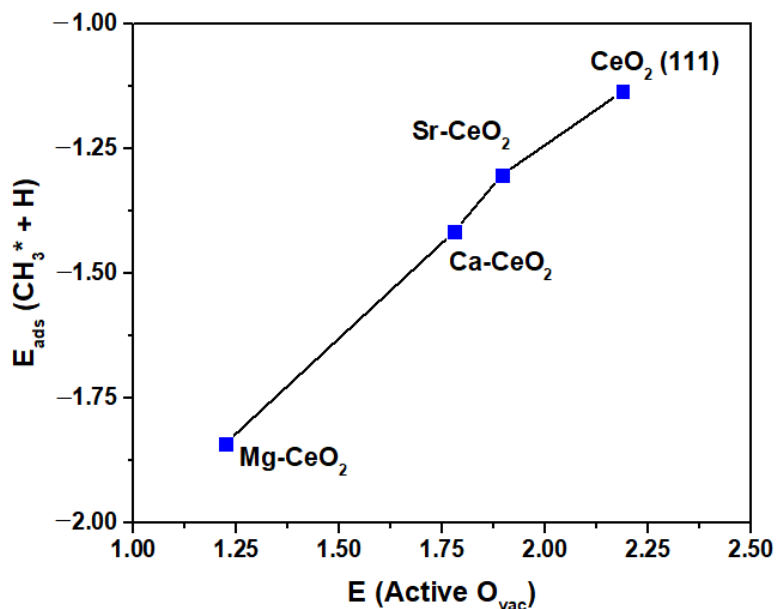
Figure 17. The correlation between the adsorption energy of the dissociation products and the formation energy of the active oxygen vacancy on the bare and doped (111) surfaces of CeO 2 , where CH 3 * is the surface-adsorbed CH 3 species). Adapted from Ref. [168]. Copyright© 2016, Royal Society of Chemistry.